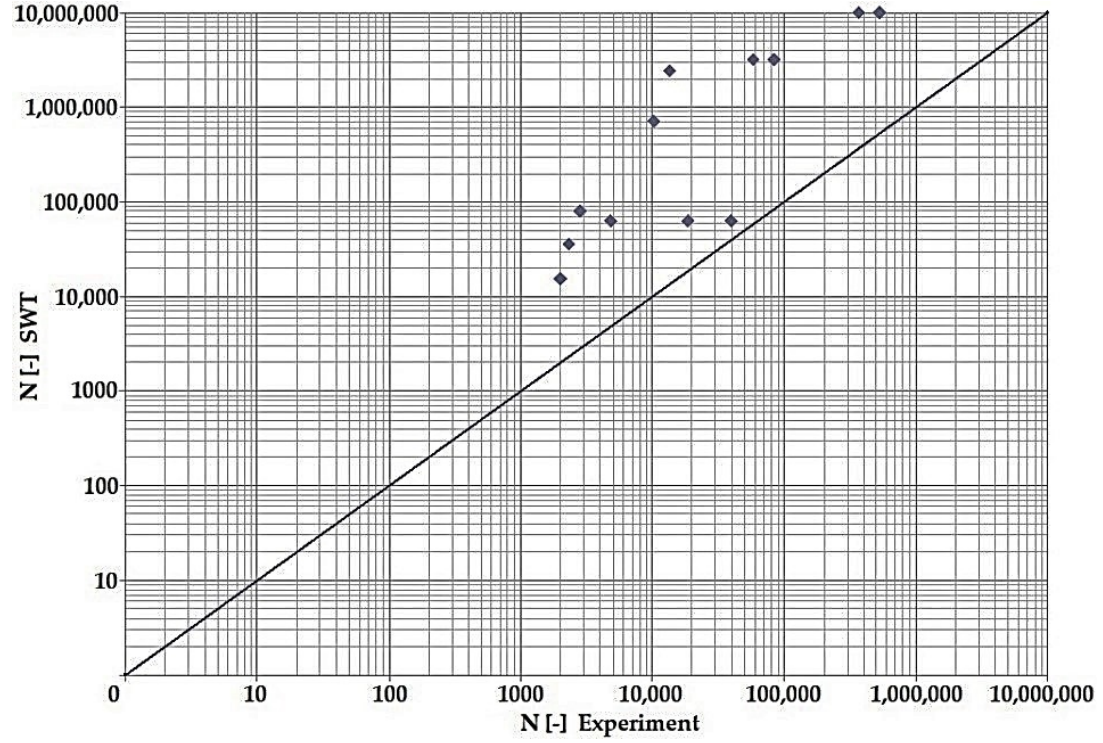
Figure 24. Dependence of theoretical and experimentally obtained number of cycles, SWT vs. experiment, phase shift 90°.